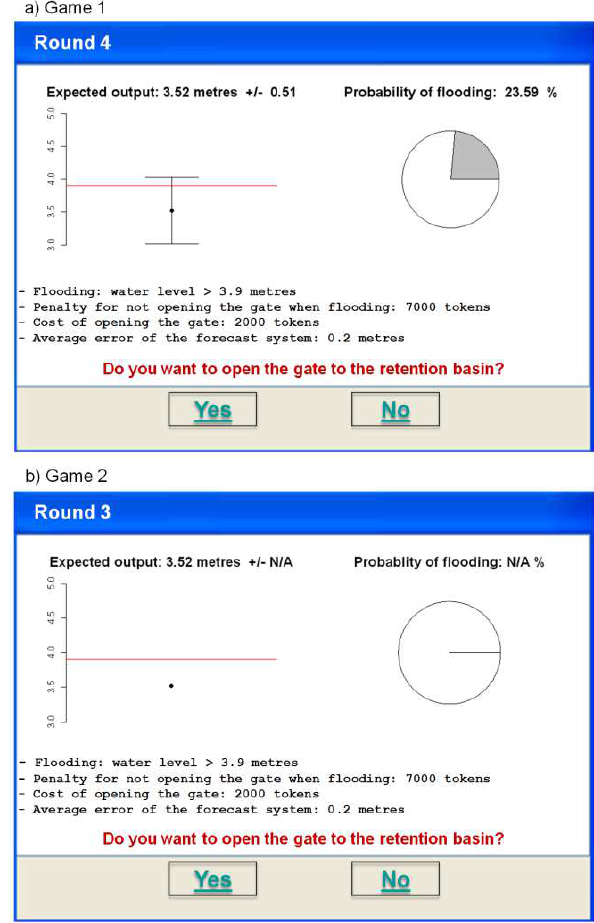
Fig. 2. Example of the rounds as they were presented to participants for their decision-making: during Game 1 with uncertainty infor- Figure 2. Example of the rounds as they were presented to participants for their 3 mation (top panel); during Game 2 without uncertainty information decision-making: during Game 1 with uncertainty information (top); during Game 2 4 (bottom panel). Only the last two rounds of Game 2 showed ± error without uncertainty information (bottom). Only the last two rounds of Game 2 showed 5 bands in additional to the expected output +/- error bands in additional to the expected output value. 6 7